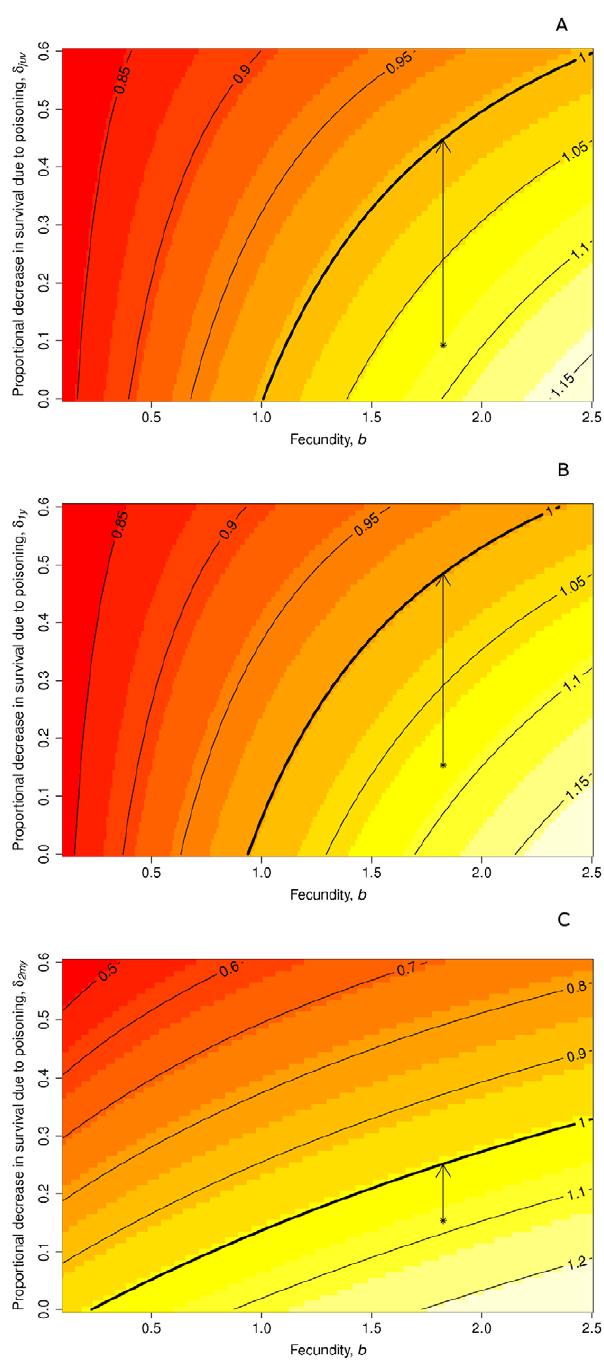
Figure 3. Difference between the proportional changes in age- specific survival probability due to illegal poisoning, fecundity, and population growth rate. The bold line represents population stability. The asterisks refer to the current parameter estimates, while arrows represent a theoretical increase in d up to the level of population stability. a) juveniles. b) 1 year old. c) 2 or more year old red kites.